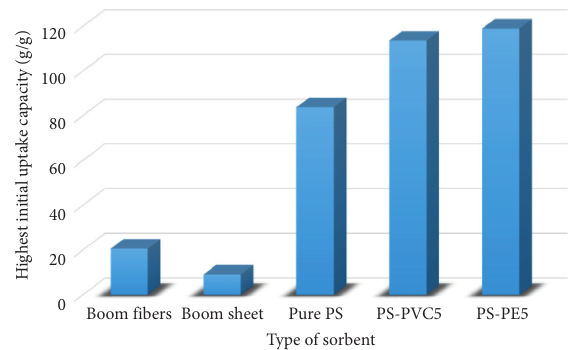
Figure 9: Highest uptake capacity of pure PS, PS-PE 5, and PS- PVC 5 fibrous sorbents, as compared to those of a commercially available boom fiber and sheet to crude oil